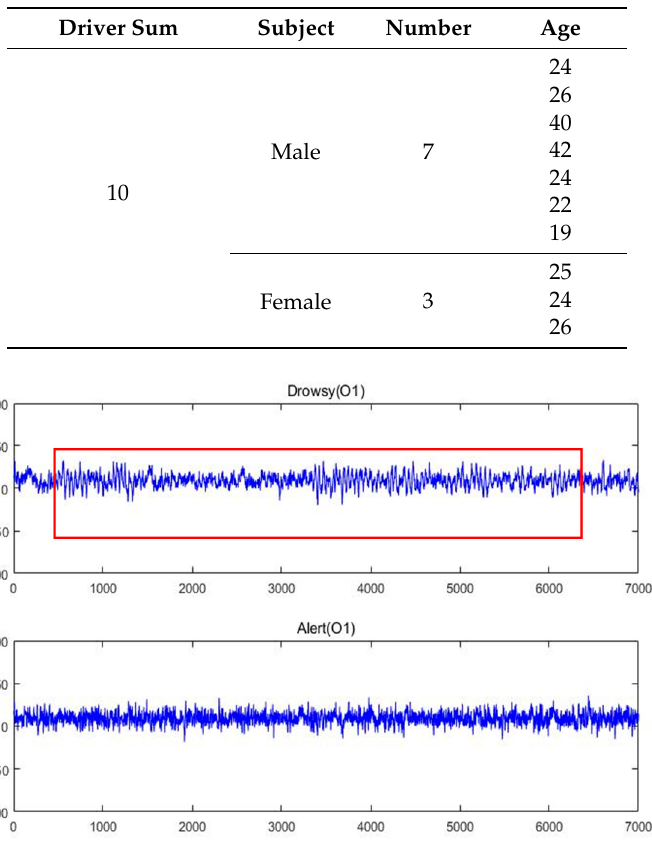
Figure 12. Raw EEG signal in alert and drowsy states from our equipment.